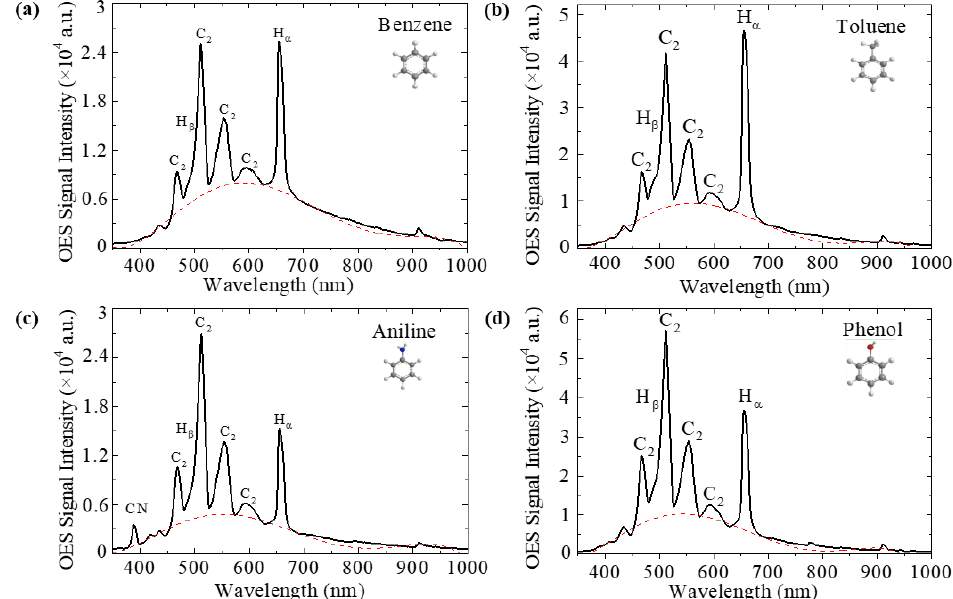
Figure 3. The SROES characterization of ( a ) benzene, ( b ) toluene, ( c ) phenol, and ( d ) aniline. (CN particles transit from B 2 Σ + to X 2 Σ + at 388 nm, Swan bands of C 2 diatomic molecules transit from d 3 Π g to a 3 Π u at the range of 400 – 630 nm, and Balmer atomic hydrogen (H α ) is at 656 nm. The continuum evident in the spectral lines in the measurement range of 340 – 800 nm was fitted by the red dashed line).